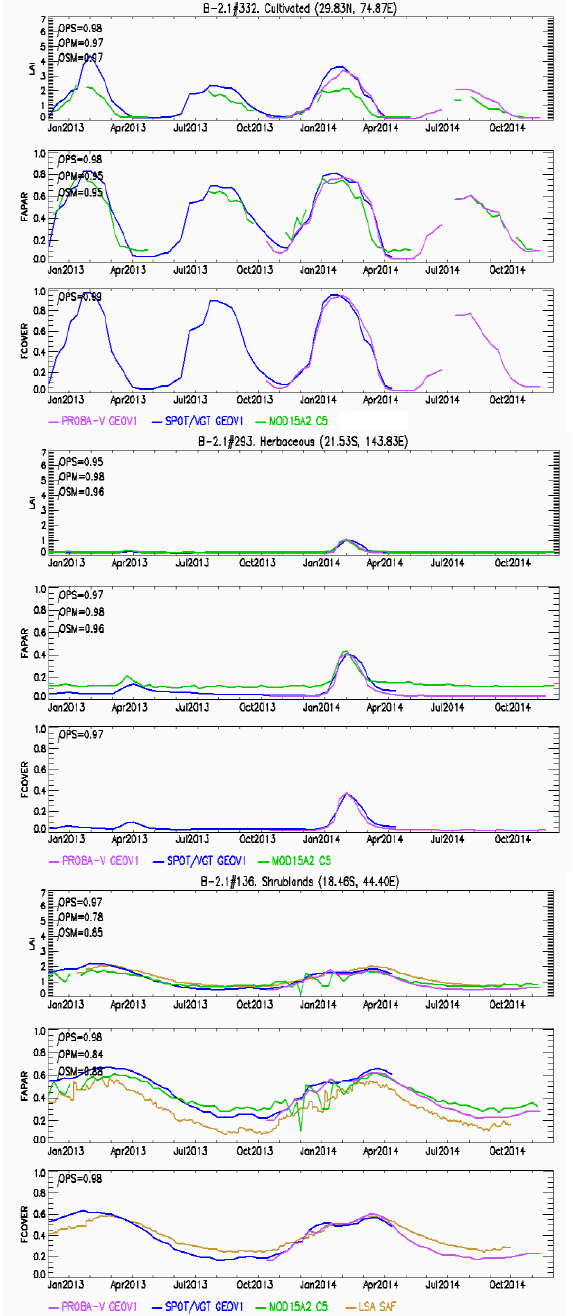
Figure 9: Temporal profiles of LAI (top), FAPAR (middle) and FCover (bottom) values of each product (PROBA-V GEOV1, SPOT/VGT GEOV1, MODIS C5 and LSA SAF) for selected sites of each biome type.